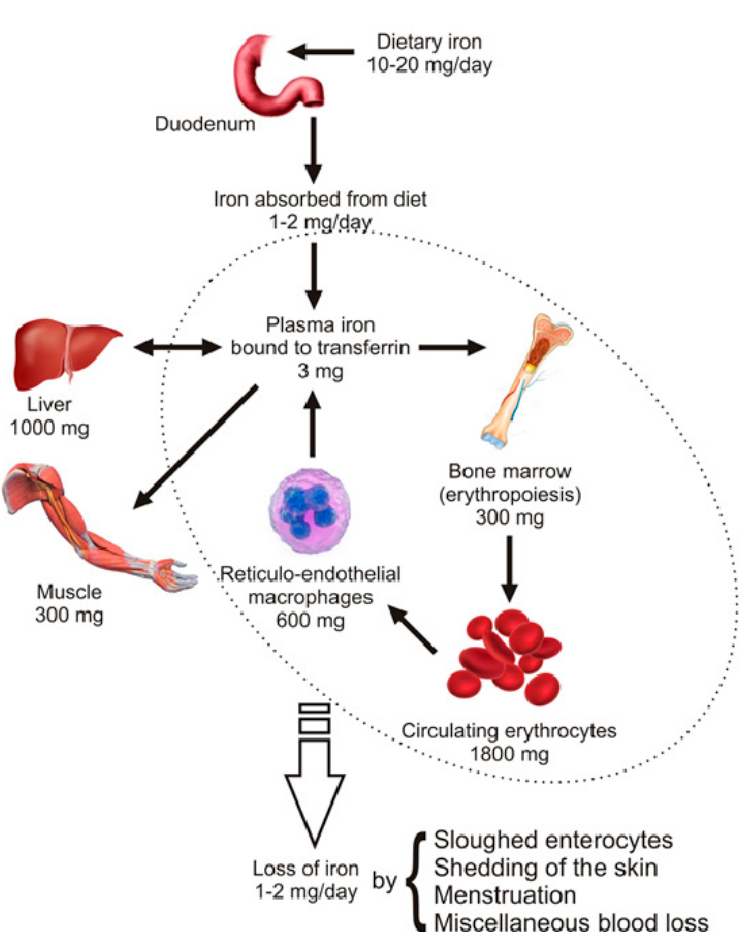
Figure 1. Distribution of body iron. The adult human body has approximately 4 g of iron, with more than half ( > 2 g) incorporated in the haemoglobin of developing erythroid precursors (300 mg) and mature circulating erytrocytes (1800 mg). The remaining body iron is found in a transit pool in reticulo-endothelial macrophages (600 mg) or stored in hepatocytes (1000 mg). A smaller part is present in muscles within myoglobin (300 mg), while only a minor amount is present in plasma bound to transferrins (Tfs,3 mg) or incorporated in other proteins and enzymes that include iron in their structures. Approximately, 10–20 mg of iron is daily consumed by diet, from which only 1–2 mg is absorbed. The same amount is lost every day by blood loss of di ff erent etiology, shedding of the skin and sloughed enterocytes.